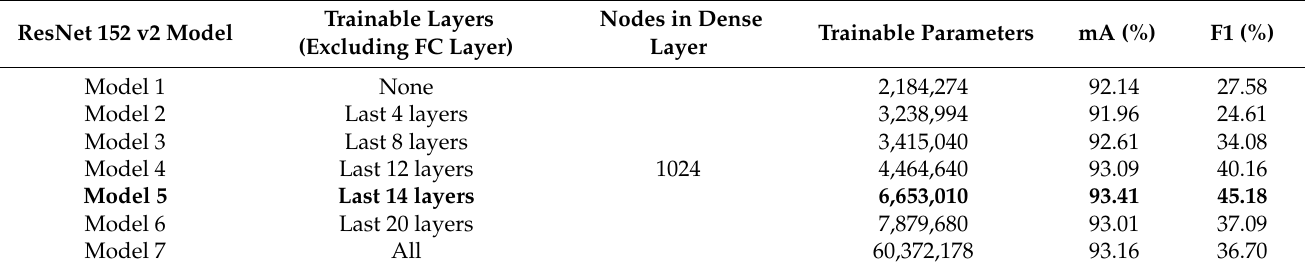
Table 3. Experiment on ResNet 152 v2 architecture on the RAP v2 dataset via the transfer learn- ing